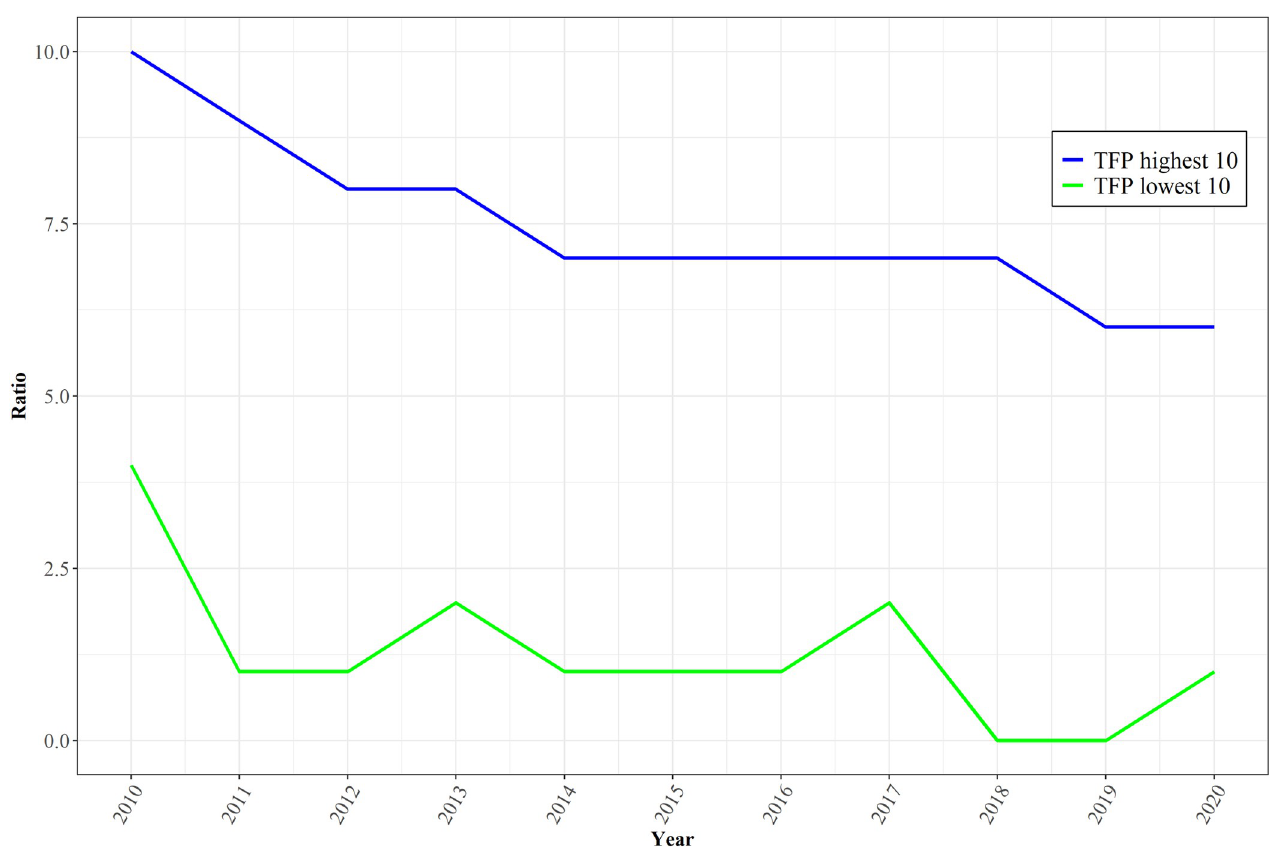
Fig 5. Actual and IMF-estimated GDP growth rates of countries with highest and lowest productivity growth calculations by IFs in 2015. Note: 2019 and 2020 were pre-pandemic estimates, other years are data. Source: IFs Version 7.61 and IMF World Economic Outlook 2019.